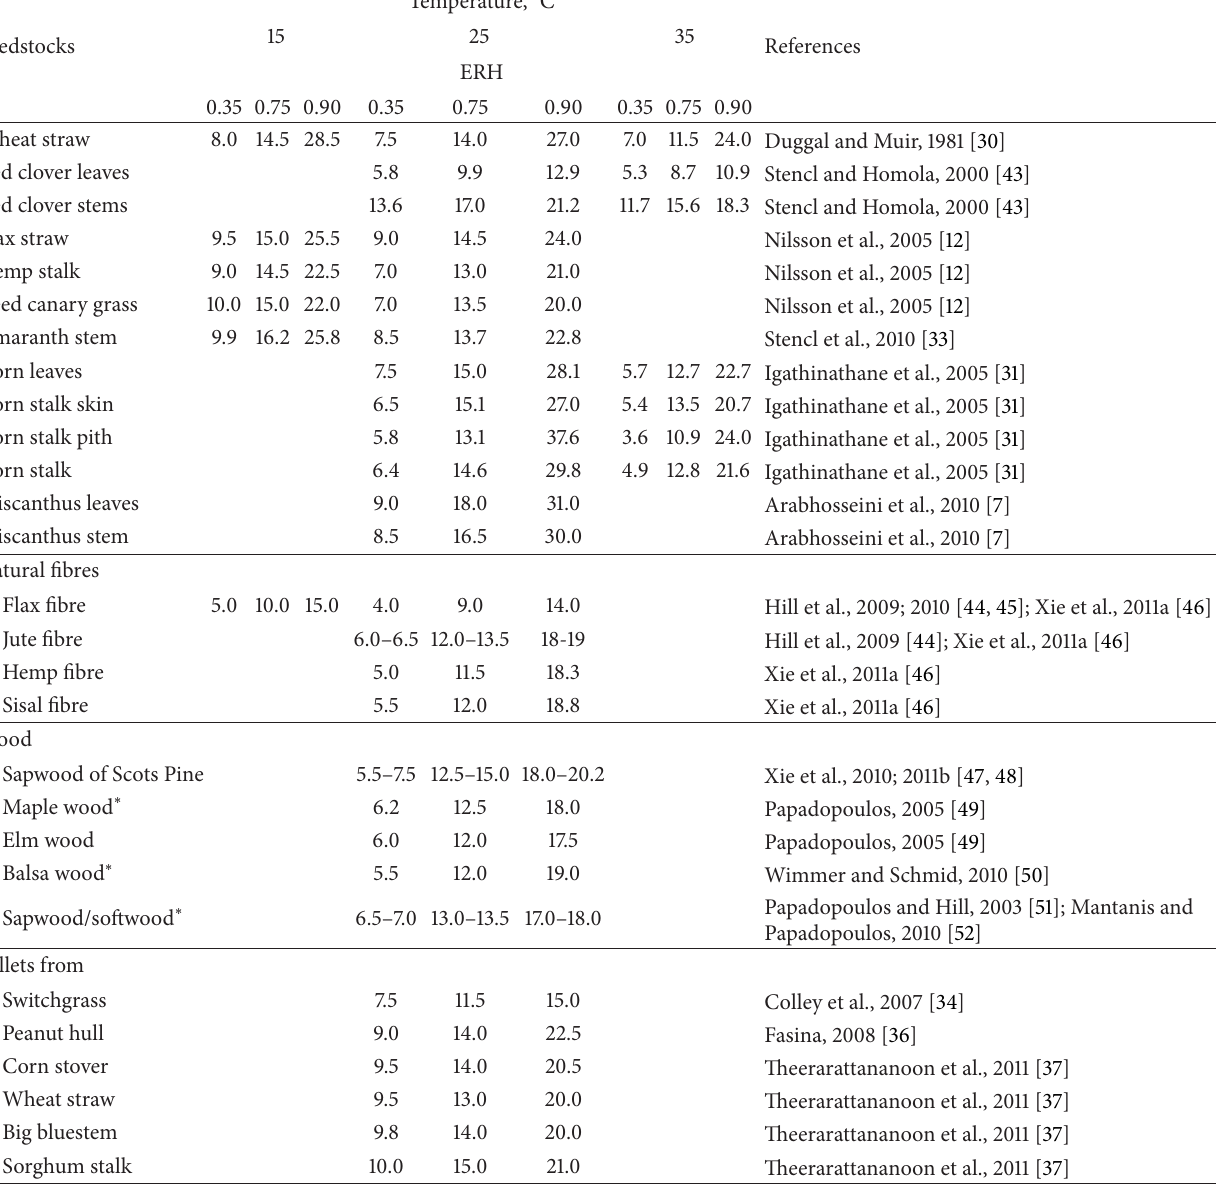
Table 3: EMC (% db) of different feedstocks and pellets found in